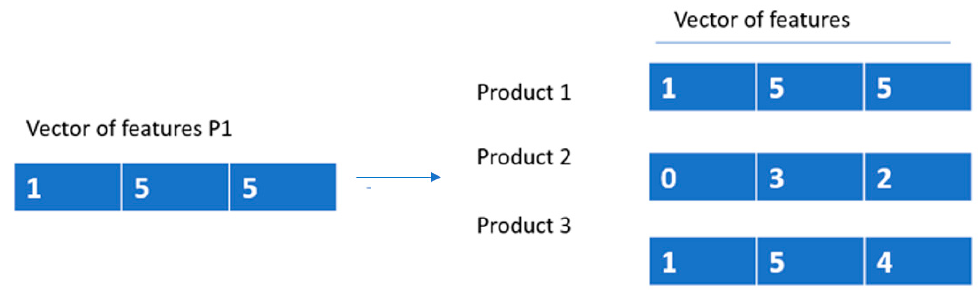
Figure 4. Creation of the vector of features to each Product.